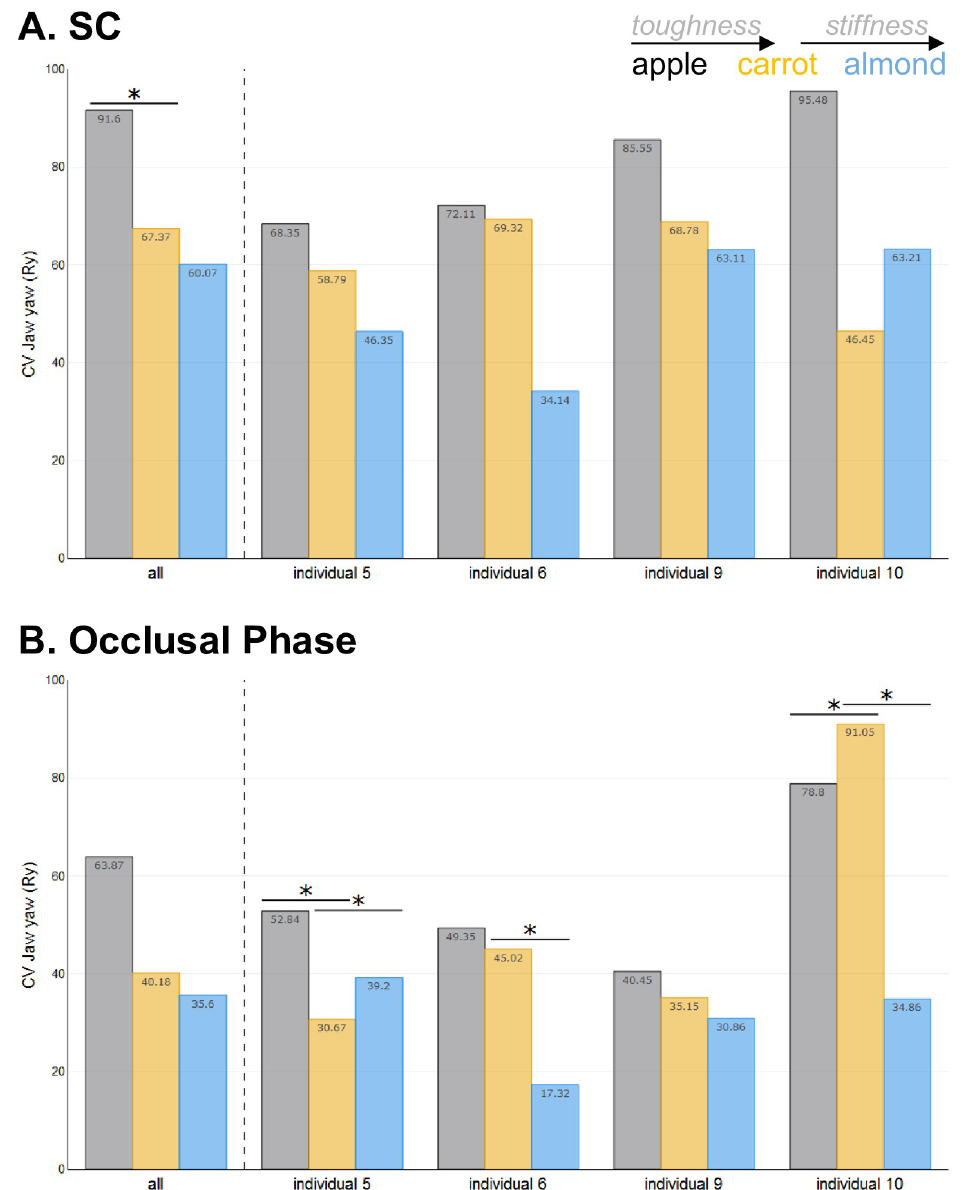
Fig 6. Effect of toughness and stiffness on the within-food variability of jaw yaw amplitude. CV indicates the level of stereotypy in the amplitude of Ry for each food: A) during SC and B) during tooth occlusion (when present). Colors represent foods: apples in black, carrots in orange and almonds in blue. Significant differences between foods are indicated by an � .